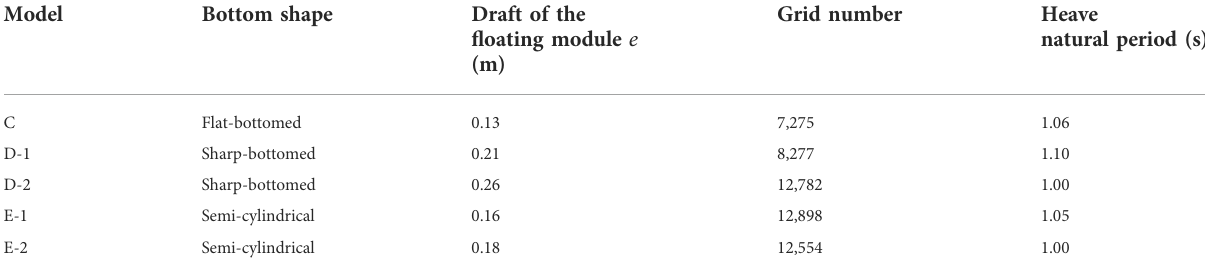
TABLE 5 Model parameters of fi ve different bottom shapes of the buoyancy module.